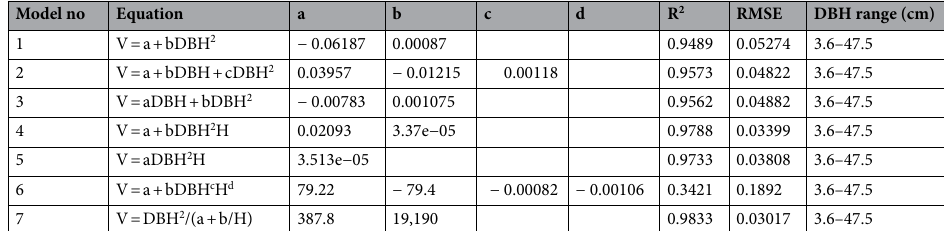
Table 3. Coefficient and fit statistics of different stem volume